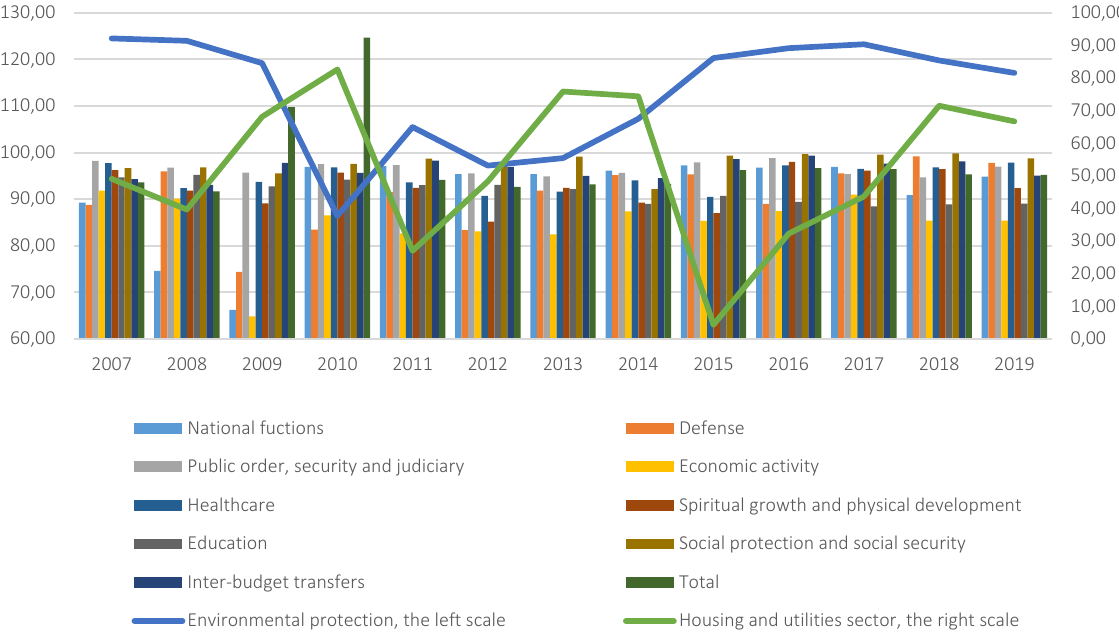
Figure 1. Execution of expenditures of Ukraine’s state budget, %